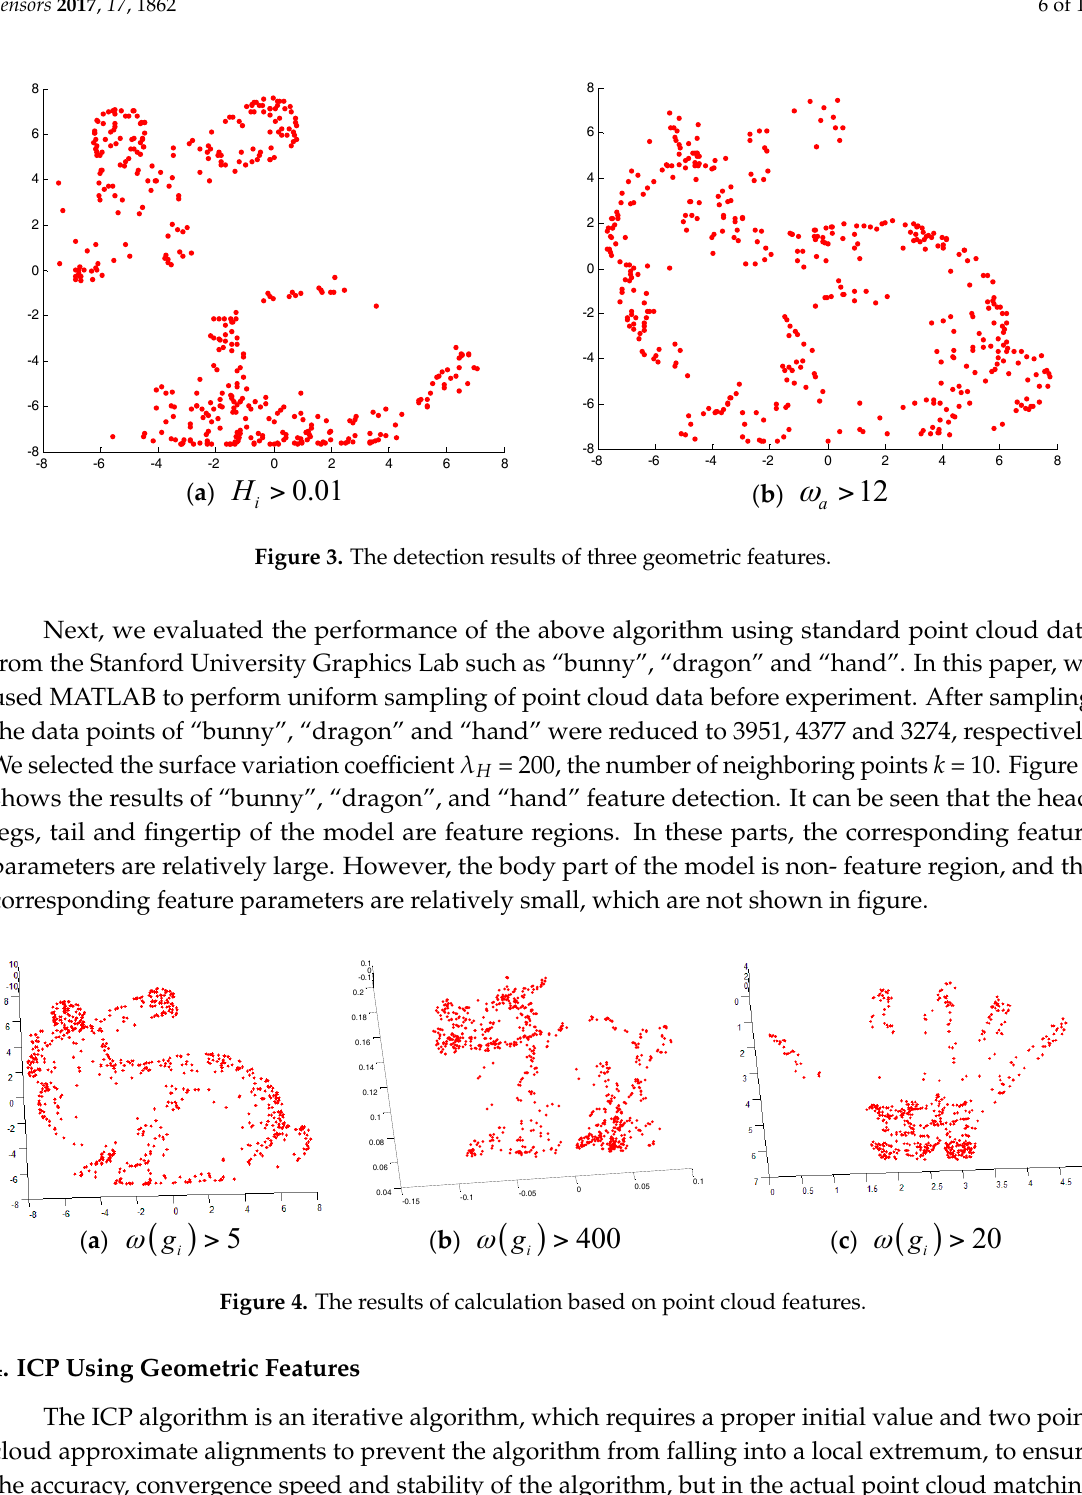
Figure 2. The detection results of feature points and non-feature points.